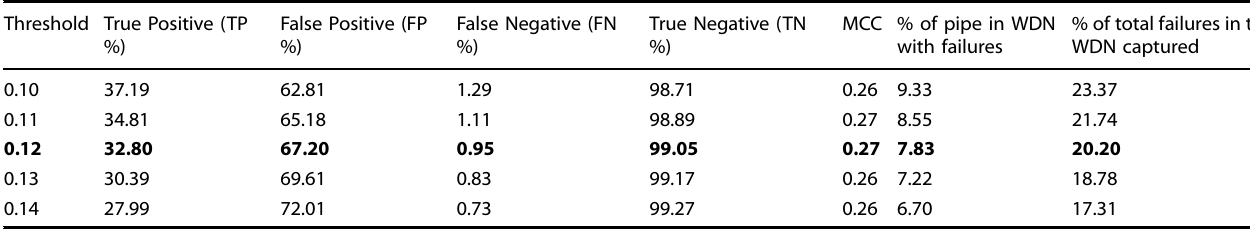
Table 1. Table of thresholds from training data.